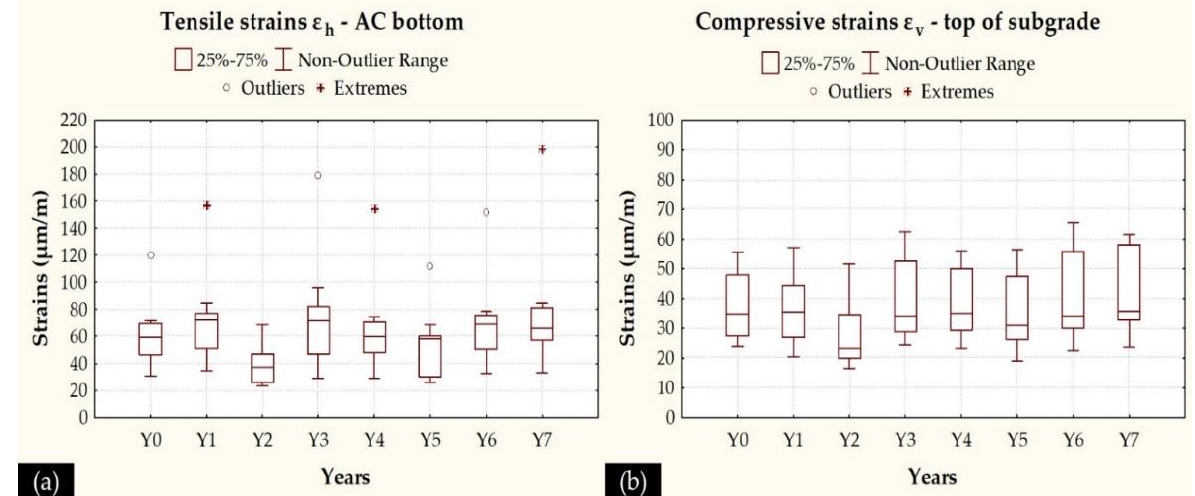
Figure 12. ( a ) Tensile strains at the AC bottom, and ( b ) compressive strains at the top of subgrade.